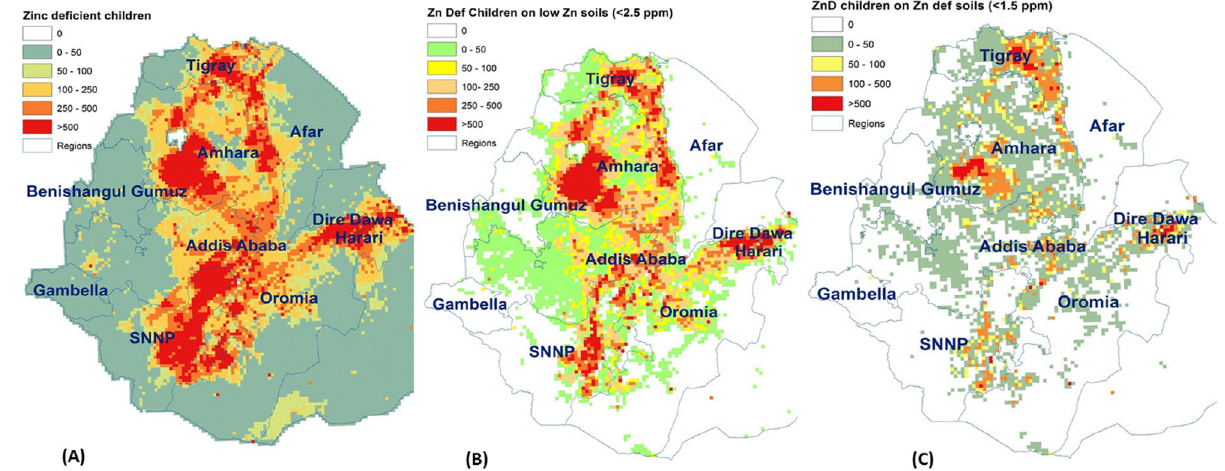
Figure 6. Mapping the number of zinc-deficient children, by zinc soil type (map produced with ArcGIS Desktop version 10.8.1 from ESRI, https:// www. esri. com/ en- us/ arcgis/ produ cts/ arcgis- deskt op/ overv iew). Children under five Zinc deficient children under five On low Zn soils with All, from crops On low Zn soils with crops extrapolation < 2.5 All, from ENMS < 2.5 mg/kg < 1.5 mg/kg All